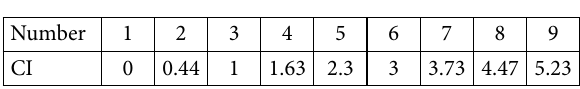
Table 2. Values of